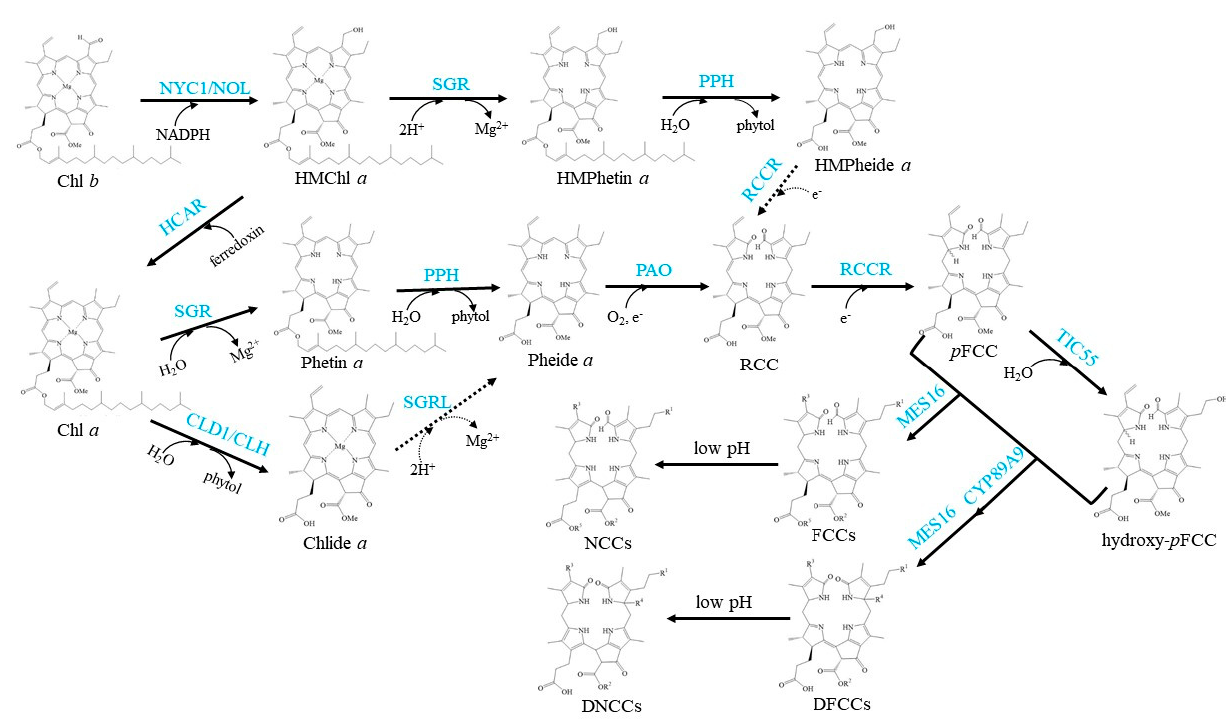
Figure 3. Schemes of the enzymatic reactions in Chl degradation. Arrows show metabolic reactions; Dotted arrows indicate the proposed reactions that need further investigation; Blue characters indicate the enzymes.